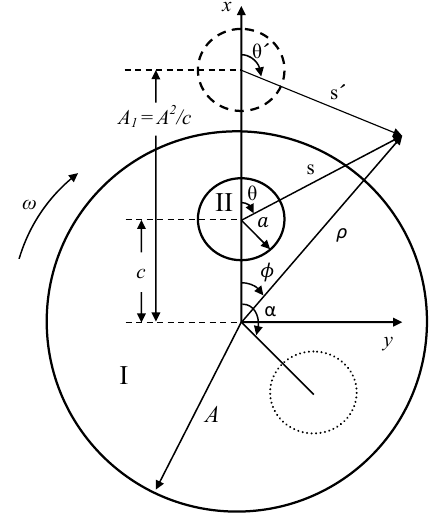
Figure 1: Plan view of the disk showing the axis, the polar coordinates we use in our calculations, the dimensions, and the Regions I and II for pole 1. The solid circle is the bound- ary of region II where the applied magnetic field of the first pole is uniform. The dashed circle refers to the boundary of the image cylinder defined in the text. The dotted circle is the boundary of a second magnetic pole displaced in space by an angle α from the first